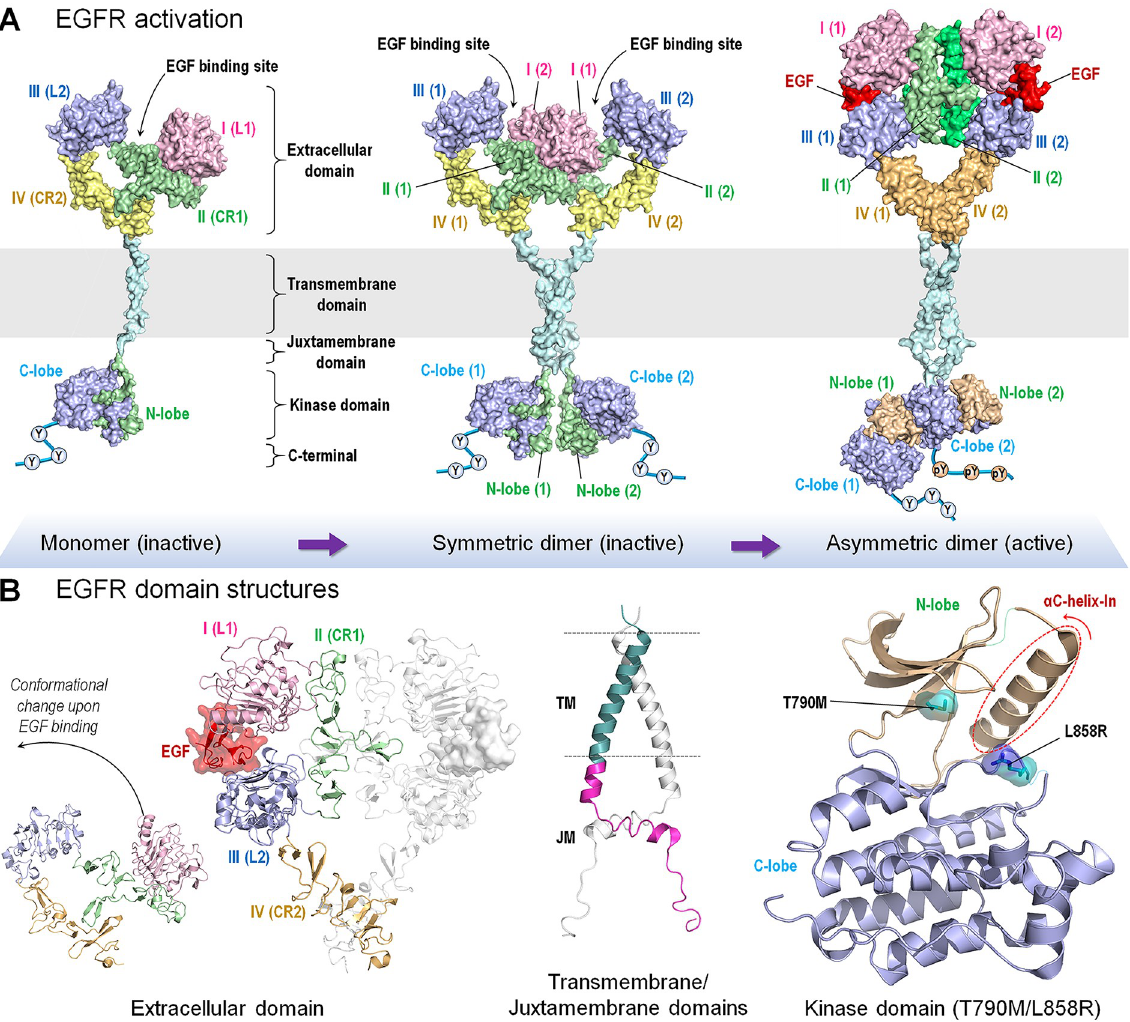
Fig 7. EGFR dimerization and activation. (A) Model for ligand-induced homodimerization of EGFR. The inactive EGFR monomer forms a symmetric dimer in the inactive state. Ligand binding to the extracellular domain shifts the population to the active EGFR dimer. (B) EGF or ligand binding causes an extended conformation of the extracellular domain, promoting a conformational rearrangement through the transmembrane to juxtamembrane domains [263, 270]. This results in an asymmetric assembly of the kinase domains. In the cartoons, crystal structures of extracellular domain (PDB code: 5XWD), transmembrane domain (PDB code: 5LV6), and kinase domain (PDB code: 2GS7) were used to model the inactive monomer and symmetric dimer. The active asymmetric dimer model employs crystal structures of extracellular domain (PDB code: 3NJP), transmembrane/juxtamembrane domain (PDB code: 2M20), and kinase domain (PDB code: 2GS6). Spheres in the C-terminal tail represent tyrosine (Y) and phosphorylated tyrosine (pY) residues. The mutant kinase domain cartoon employs crystal